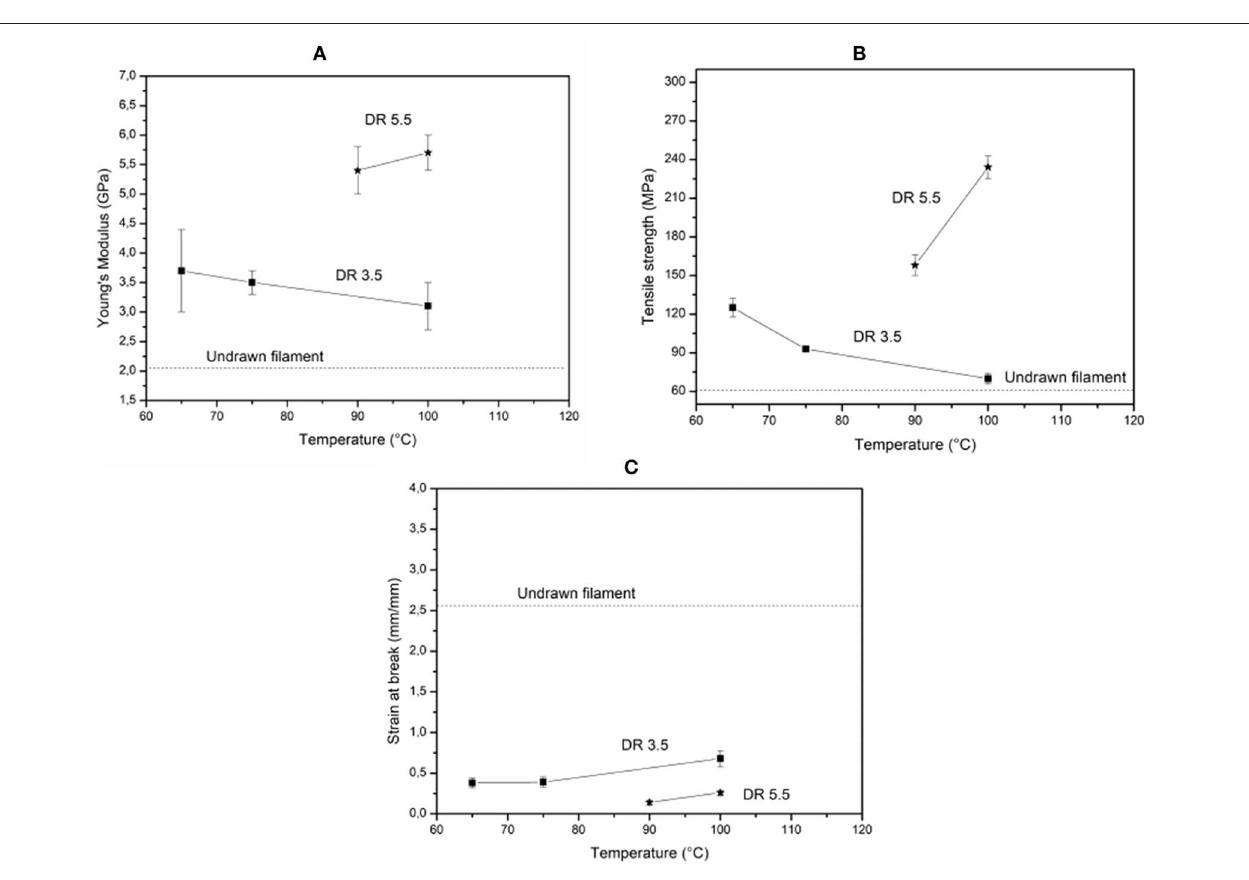
In order to better observe the differences in the surface topography of undrawn and drawn filaments, etching was performed using a sodium hydroxide (NaOH) solution which has been reported to etch the PLA amorphous fraction as a result of the hydrolysis of ester linkage (Sun et al., 2009; Jain et